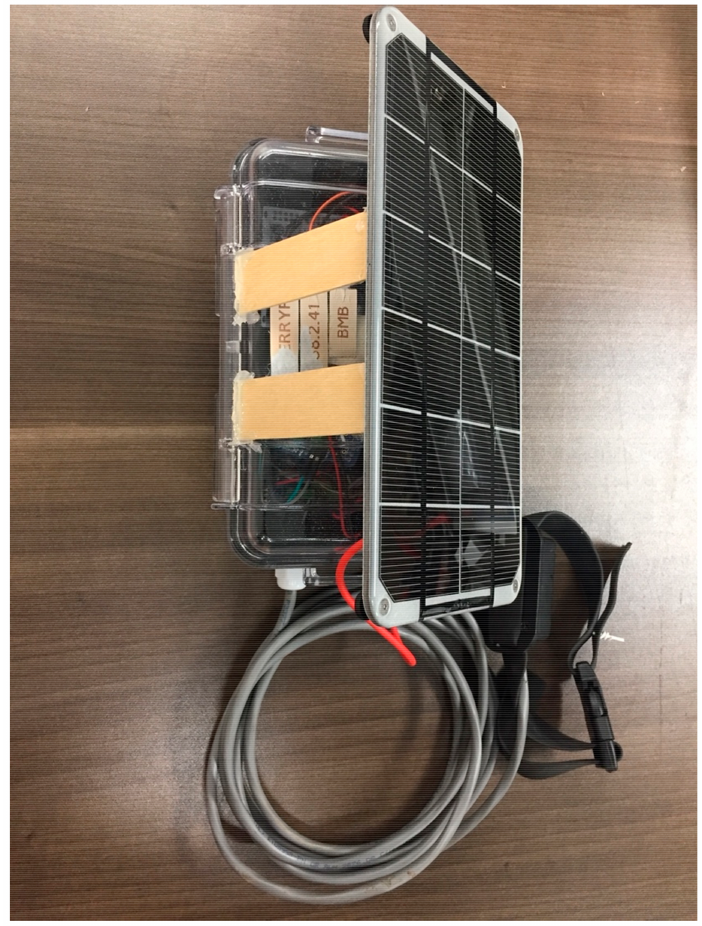
Figure 8. Solar-powered CIWS computational node